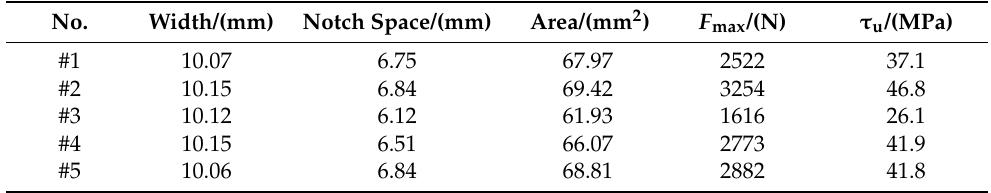
Table 2. Interlaminar shear properties of the 12k T-700 TM MWK–N–C/SiC